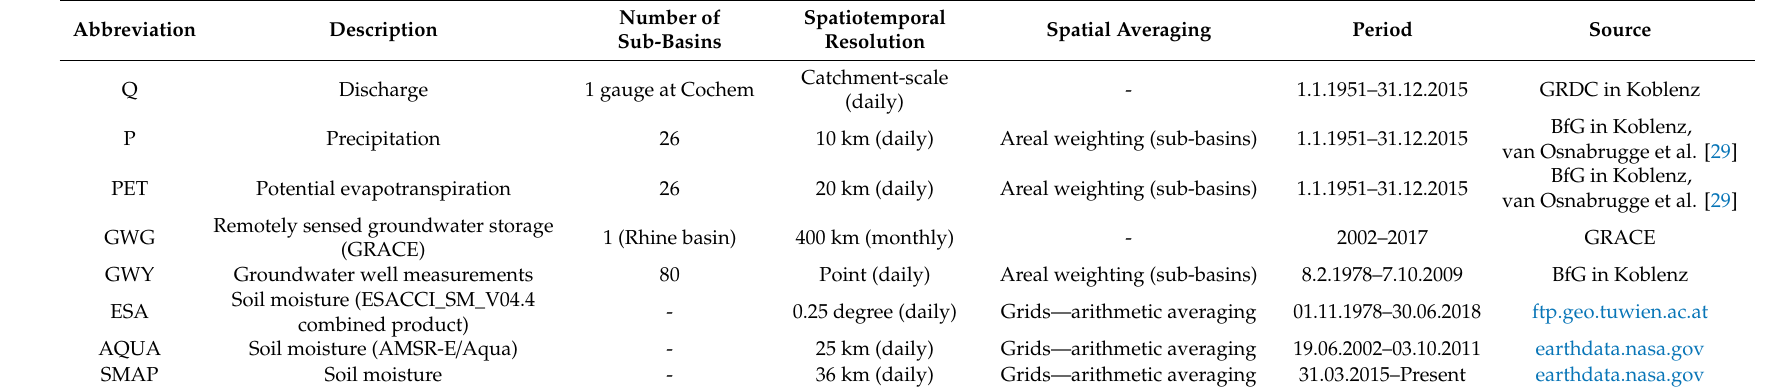
Table 1. Overview of remote sensing and hydro-meteorological